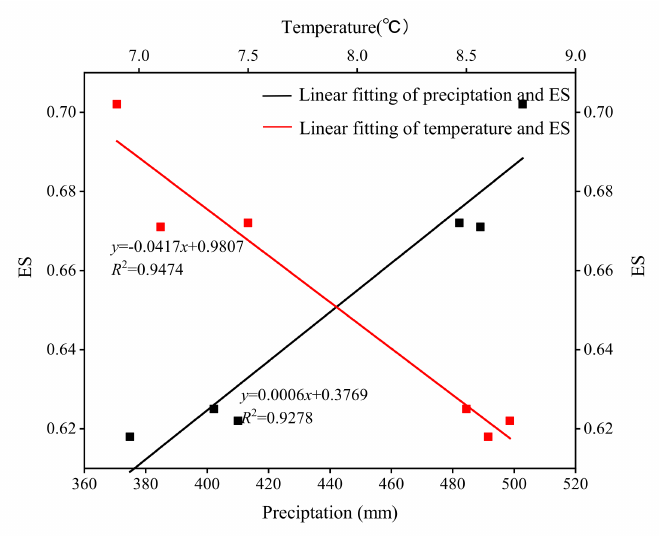
Figure 7. The relationship between ecological stability, precipitation, and